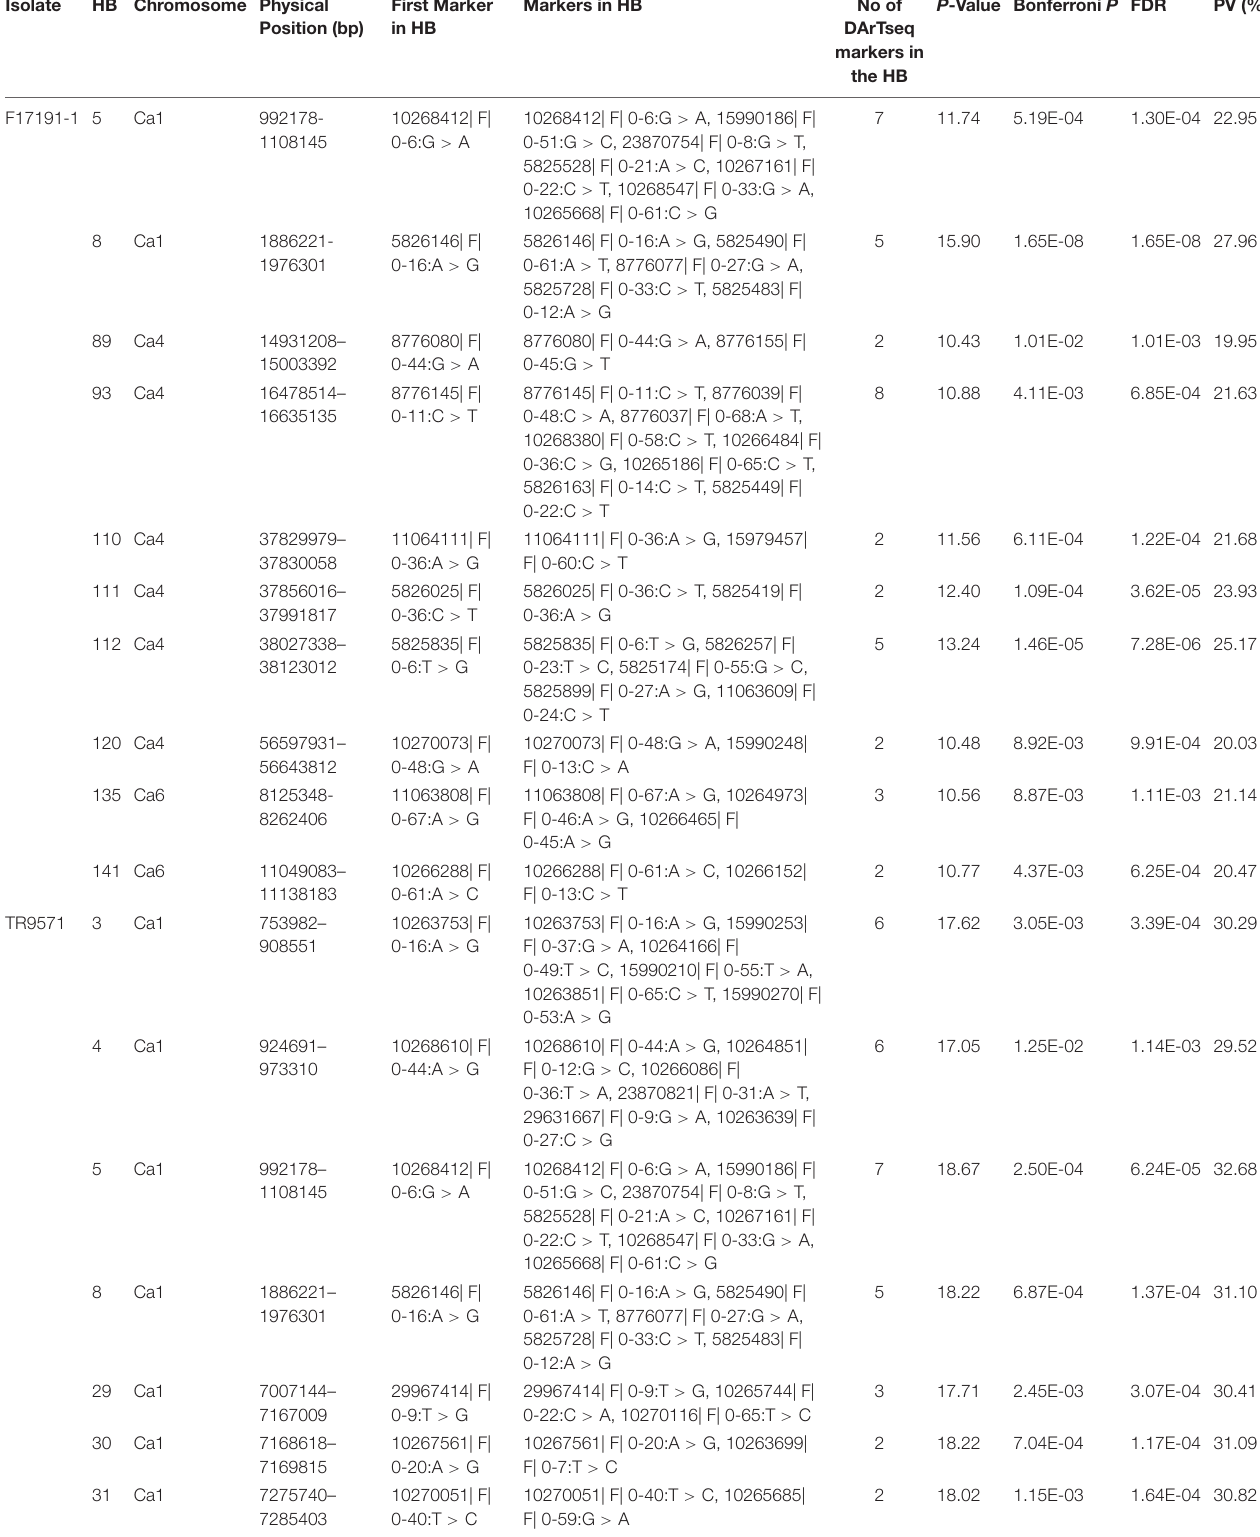
TABLE 3 | Summary of genetic loci associated with resistance against two Ascochyta rabiei isolates using Haplotype Trend Regression (HTR) in a GWAS set of Australian chickpea breeding genotypes.